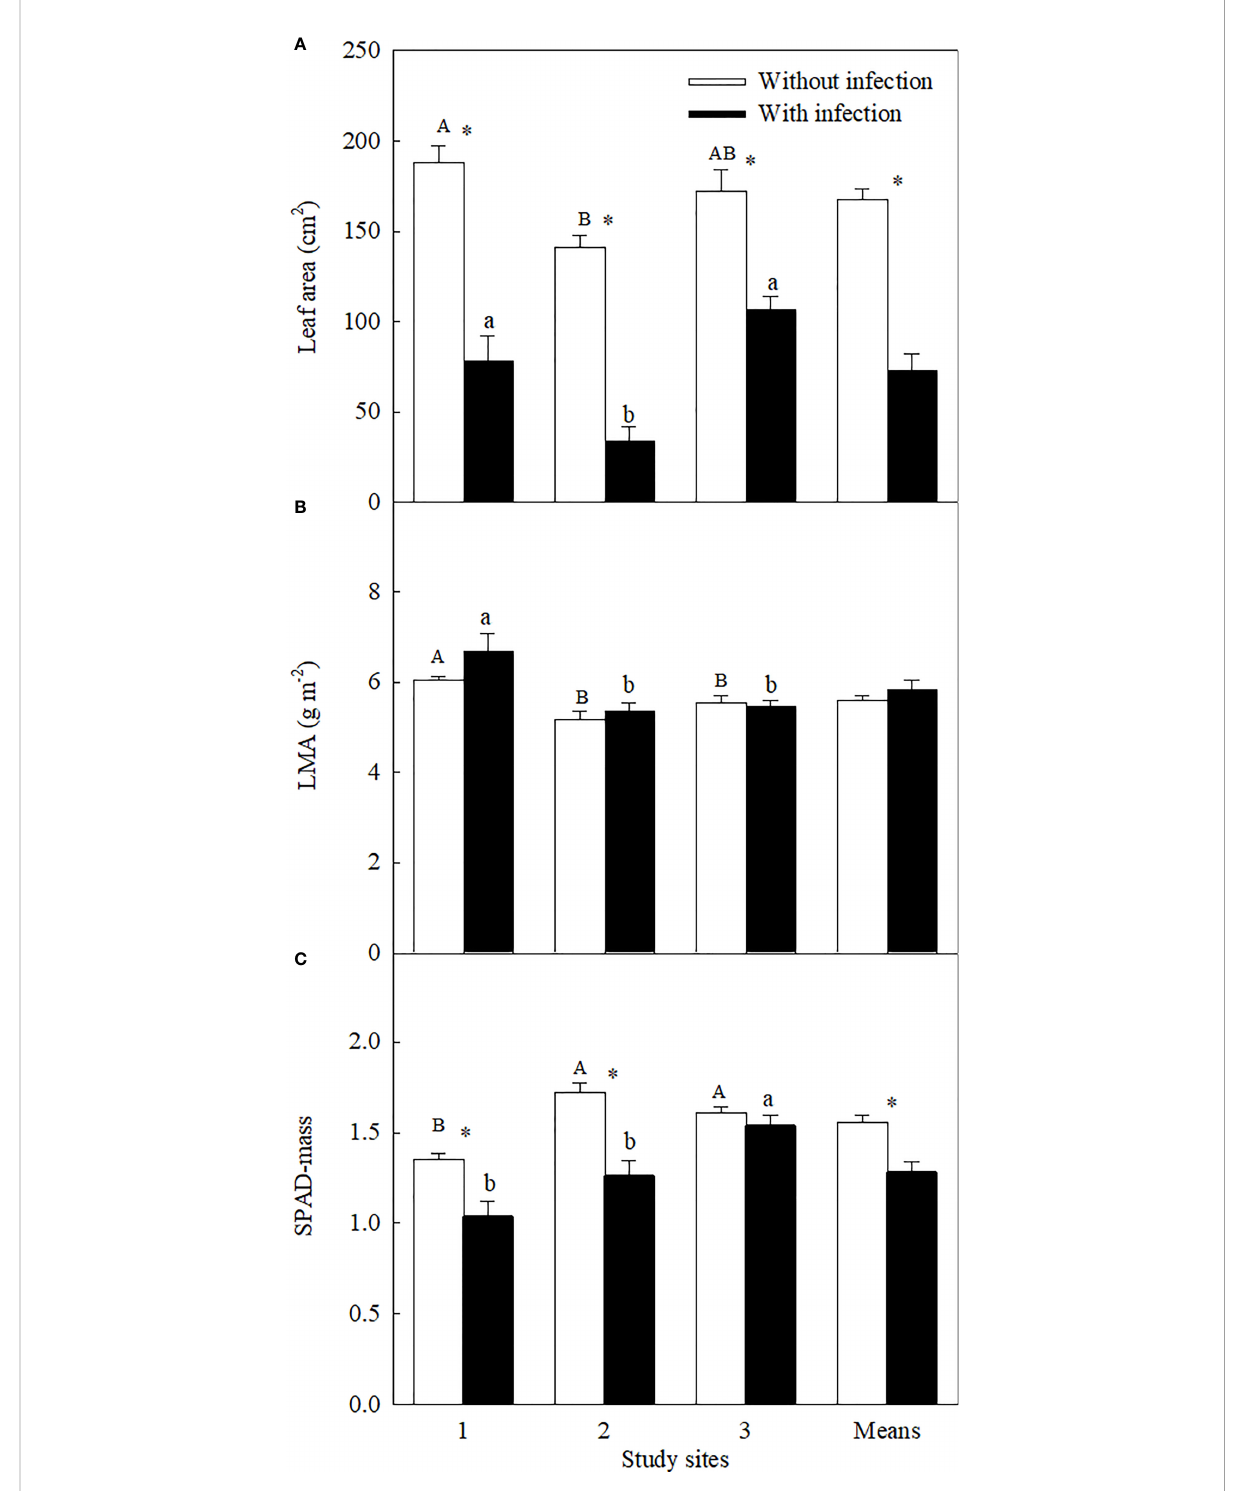
FIGURE 3 Leaf area (A) , leaf dry mass per unit area (LMA, square-root-transformed; (B) , and leaf relative chlorophyll content (mass-based SPAD; (C) of Ambrosia tri fi da uninfected (open bars) and infected (closed bars) by Cuscuta japonica at different sites. Means + 1 SE ( n = 6). Different upper- and lowercase letters indicate signi fi cant differences among sites for uninfected and infected plants, respectively ( P < 0.05; one-way ANOVA); * indicates signi fi cant difference between uninfected and infected plants at the same site ( P < 0.05; independent sample t